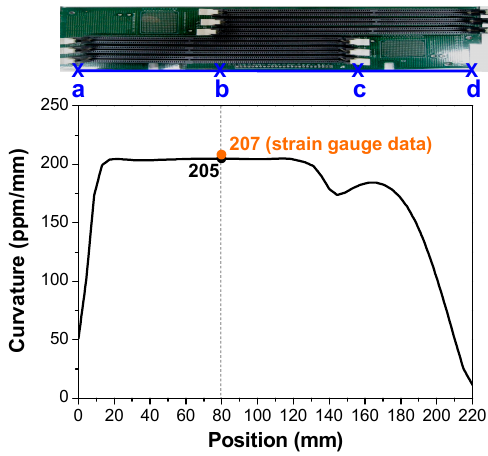
Figure 9. Curvature distributions along edge line a-d on the PCB assembly at room temperature after the solder reflow process from the FEM simulation, and one curvature data from the strain gauge measurement.